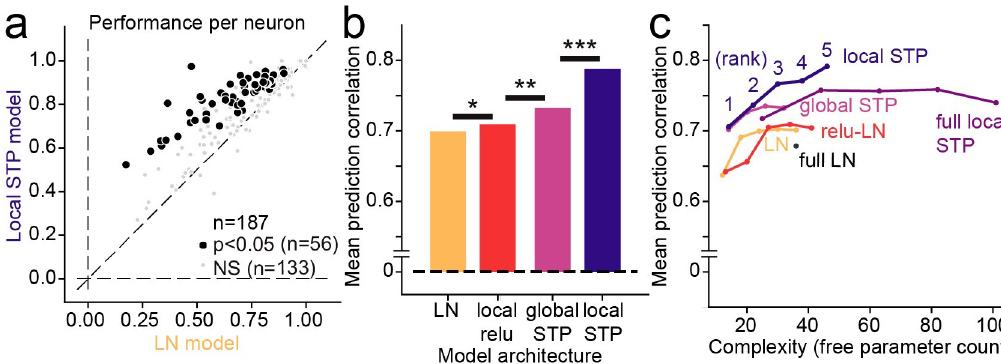
Fig 4. A. Scatter plot compares noise-corrected prediction correlation between the linear-nonlinear (LN) model and local short-term plasticity (STP) model for each A1 neuron. Black points indicate the 56/187 neurons for which the local STP model performed significantly better than the LN model ( p < 0.05, jackknifed t -test). B. Mean performance (noise-corrected correlation coefficient between predicted and actual PSTH) for each model across the set of A1 neurons. The global STP model showed improved performance over the LN and local rectification (relu) model. The local STP model showed a further improvement over the global STP model ( � p < 0.01, �� p < 10 − 4 , ��� p < 10 − 6 , Wilcoxon sign test, n = 187/200 neurons with above-chance prediction correlation for any model). The best performing model, the local STP model, reweighted the two input envelopes into five spectral channels, each of which underwent independent STP prior to linear temporal filtering and a static nonlinearity. C. Pareto plot compares model complexity (number of free parameters) versus average prediction correlation for model architectures with and without STP, with and without parameterization of the temporal filter (full vs. DO) and for variable numbers of reweighted spectral channels (rank). Models with STP showed (purple, blue) consistently better performance than models without STP (orange, red) for all levels of